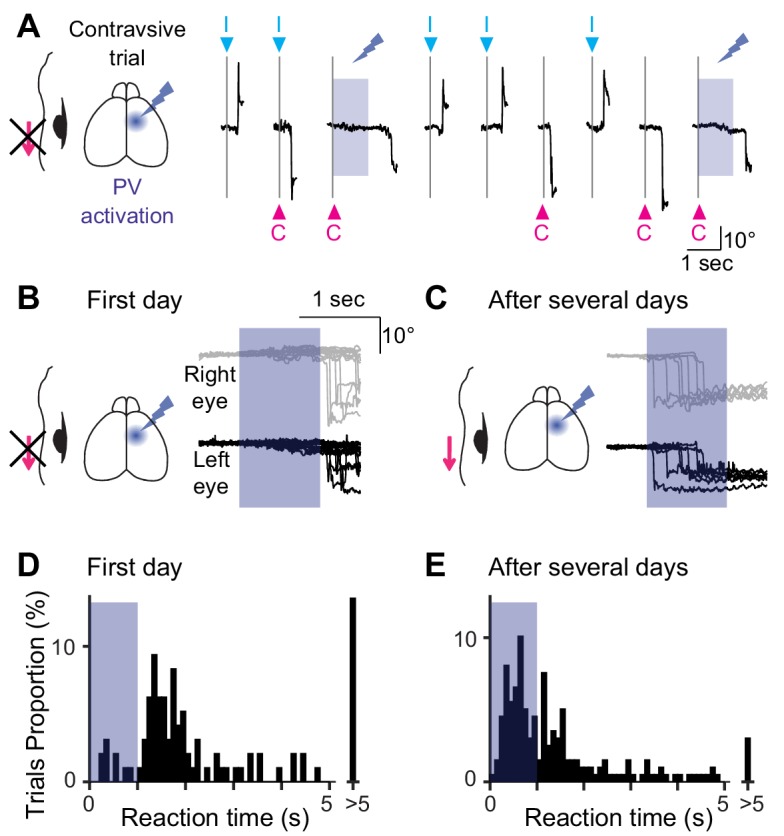
Optogenetic suppression of unilateral MOs during the visually-guided eye movement task for multiple days.(A) The experimental design and example traces of eye position from one animal. Neuronal activity of the unilateral MOs was optogenetically suppressed during the eye movement task by activating PV+ interneurons. Optogenetic suppression was induced just after visual cues (blue shaded period) only for 1 s. When the blue light was illuminated, the mice could not produce temporal eye movements for the contraversive direction. (B, C) Effect of the unilateral optogenetic suppression during the task. Example traces from one animal. The suppression severely impaired the contraversive eye movements on the first day (B) but not after 4 days (C). Traces of the bilateral eyes are shown. The blue shades indicate the optogenetic suppression period. (D, E) Distribution of reaction time for the first day (1.76 ± 1.47 s, 96 out of127 trials, eight mice) and after 5.9 ± 1.0 days (1.06 ± 1.00 s, 198 out of 220 trials, eight mice). The reaction times were significantly different (p<10−9, Mann-Whitney U test).Figure 2—source data 1.Contains numerical data plotted in Figure 2D,E.Figure 2—source code 1.Displays distributions of reaction time.